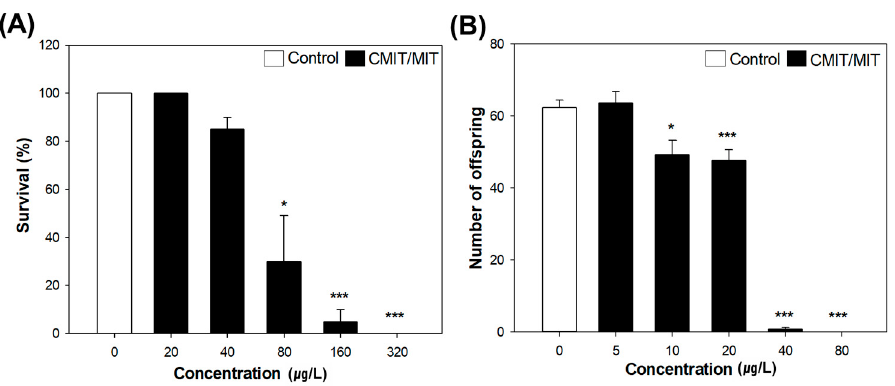
Figure 2. Effects of CMIT/MIT on mortality and reproductive capacity in D. magna : ( A ) Survival rate of daphnid neonates exposed for 48 h to 20, 40, 80, 160, and 320 µg/L CMIT/MIT. Data are presented as means ± SE (n = 4). ( B ) Total offspring numbers of adult daphnids exposed for 21 days to 5, 10, 20, 40, and 80 µg/L CMIT/MIT. Data are presented as means ± SE (n = 10). Asterisks indicate the significant differences between the exposure and control groups: * p < 0.05 and *** p < 0.001.